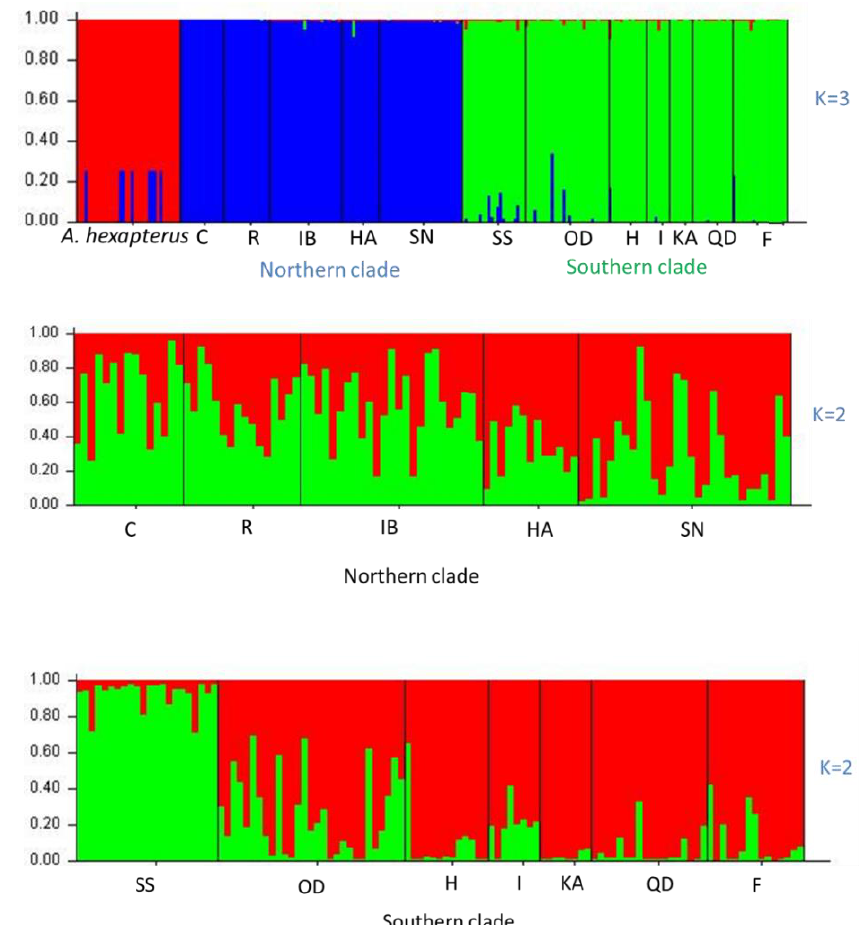
Figure 2. Spatial genetic structure for all individuals and northern and southern clades according to a Bayesian assignment probability analysis using the program STRUCTURE 2.3. K = 3 for the total data. K = 2 for northern and southern clades appeared to be the optimal number of clusters by showing the greatest ΔK. The samples ID are listed in Table 1.